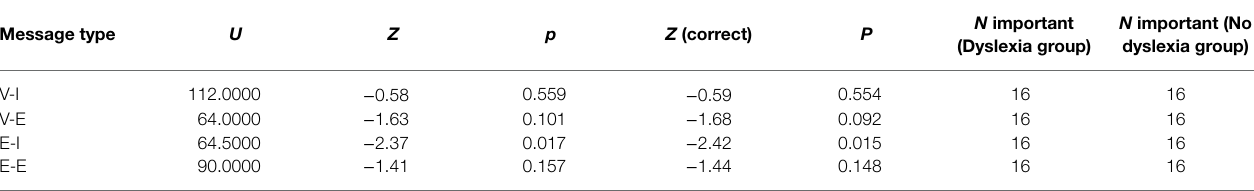
TABLE 2 | Mann-Whitney U test statistics (with the continuity correction) of the correctness of answers between groups for the four types of messages used in the study. Message